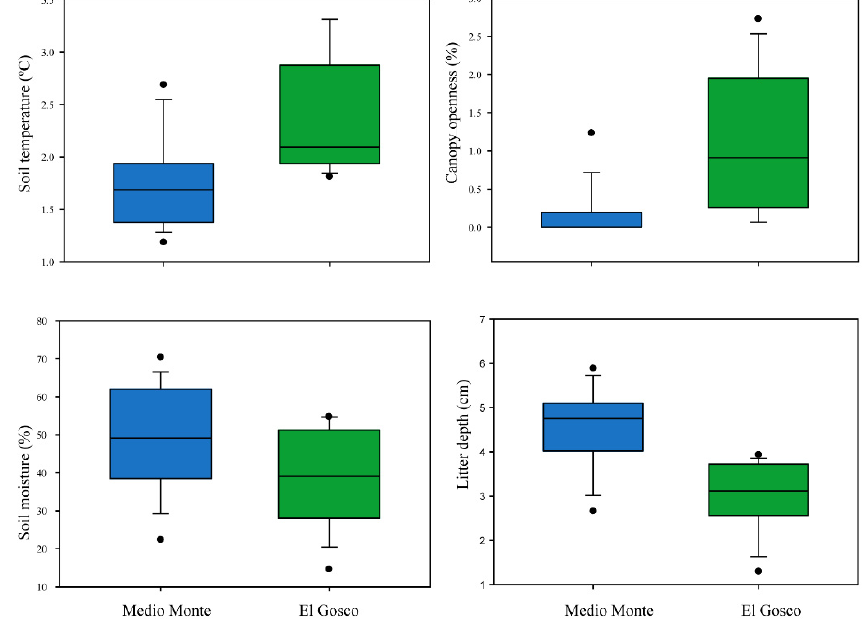
Figure 3. Box plots showing the microenvironmental fluctuations in the study forests of the Hidalgo state. The levels highs and lows in the boxes represent 75th and 25th percentiles, and whiskers represent the 90th and 10th percentiles. The circles show outliers. The solid line represents the arithmetic average and numbers within each box indicate statistically significant differences ( p < 0.05) between localities.